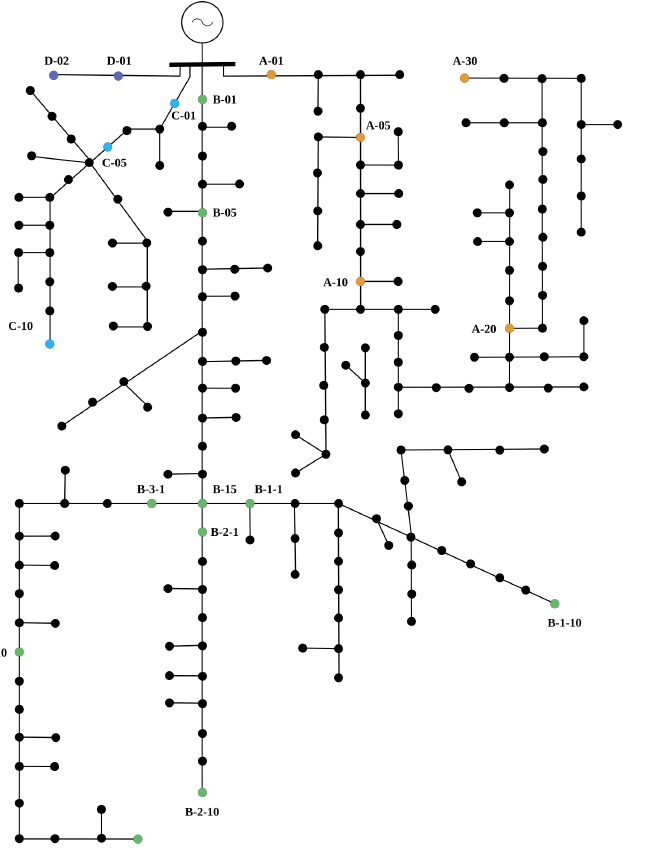
Figure 7. Current network scheme of Pantelleria island, with selected nodes in the 4